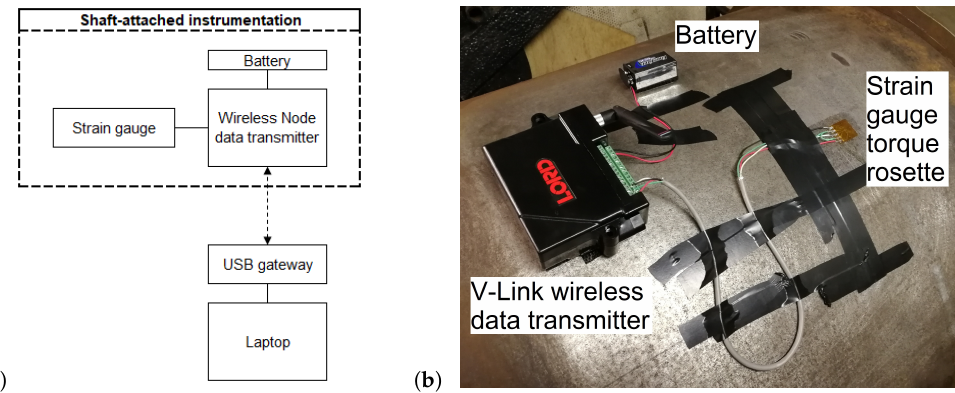
Figure 7. Arrangement of the shaft equipment ( a ); instrumentation attached to the shaft ( b